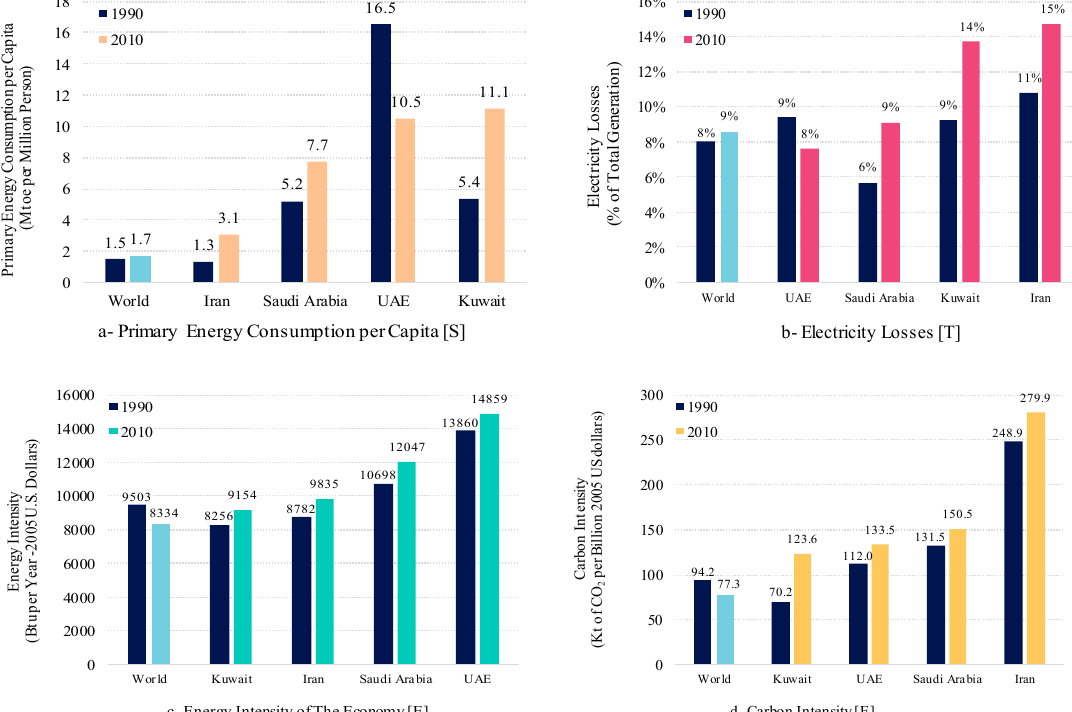
Figure 11. STEEP comparison between 1990 and 2010 values.